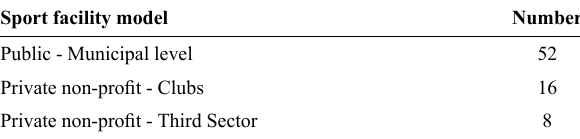
Table 2 - Sport facility model that managers